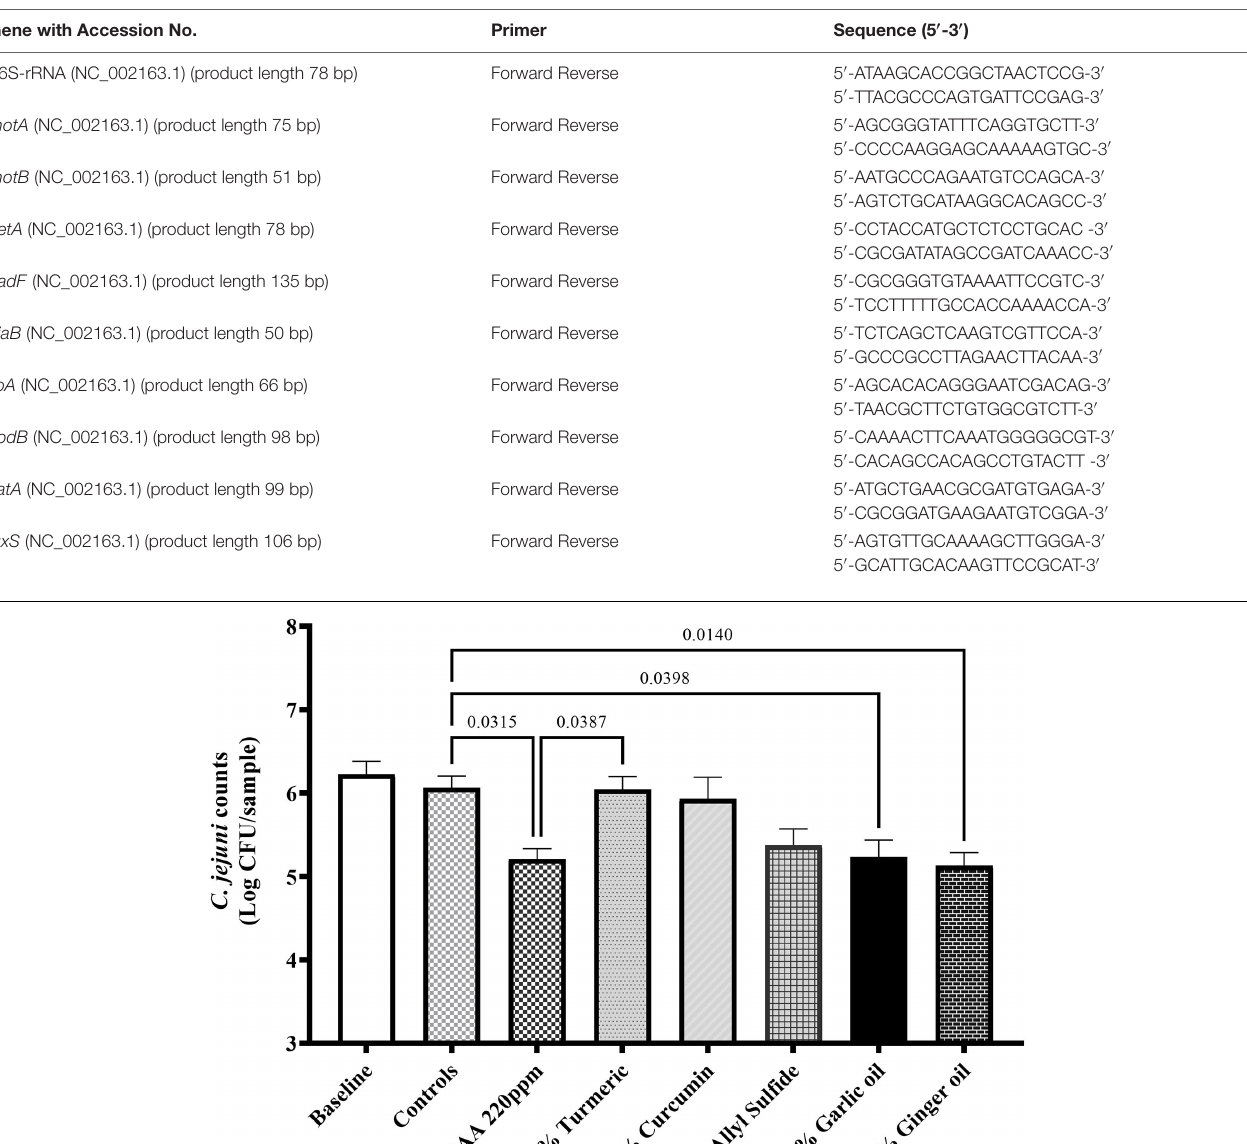
TABLE 1 | Primers used for gene expression analysis using digital droplet PCR. Gene with Accession No.